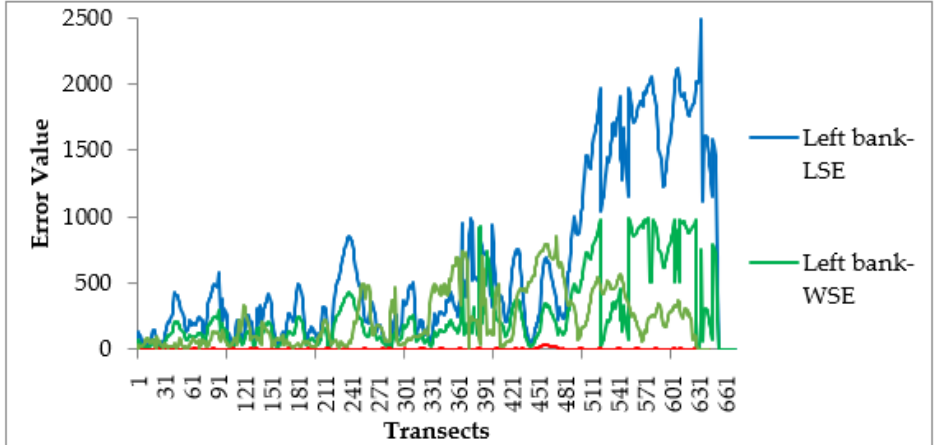
Figure 10. Standard error for LRR and WLR.